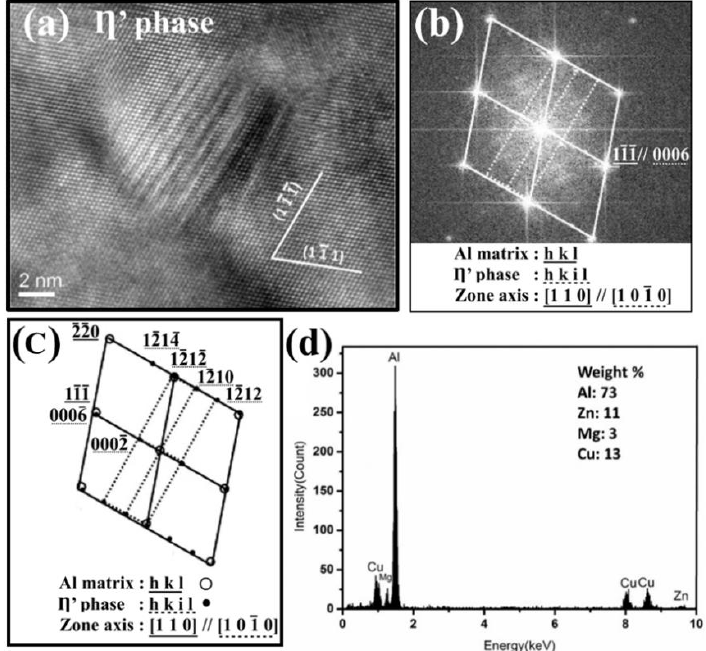
Figure 6. ( a ) HR-TEM micrograph revealing an 𝜂′ precipitate in the aluminum matrix. ( b ) Corre- sponding diffractogram by FFT; ( c ) diffraction pattern illustrations of Al matrix and 𝜂′ phase. ( d ) EDX spectrum correlating to the 𝜂′ phase.